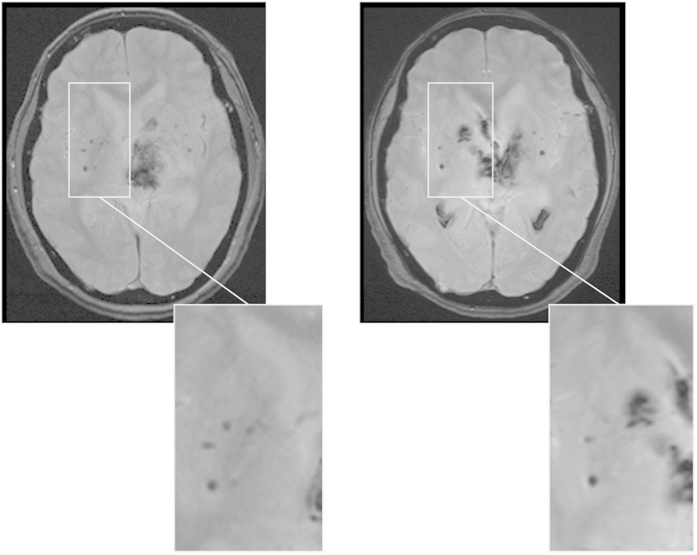
Recurrent ICH occurred in a patient with cnm-positive S. mutans.A 57-year-old woman with left putaminal hemorrhage (left) had been found to have cnm-positive S. mutans and had a recurrent hemorrhage in the right caudate nucleus with only one-year interval (right) despite good hypertension control.